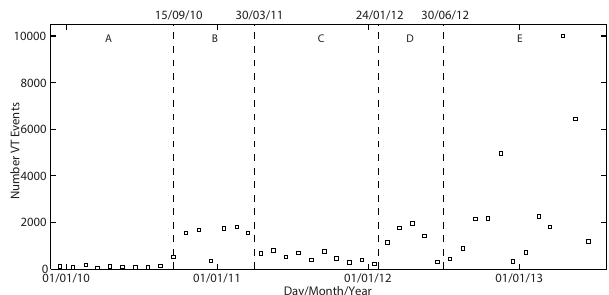
Figure 13. Number of volcano tectonic events per month. Data are taken from the SGC reports from http://www.sgc.gov.co/.